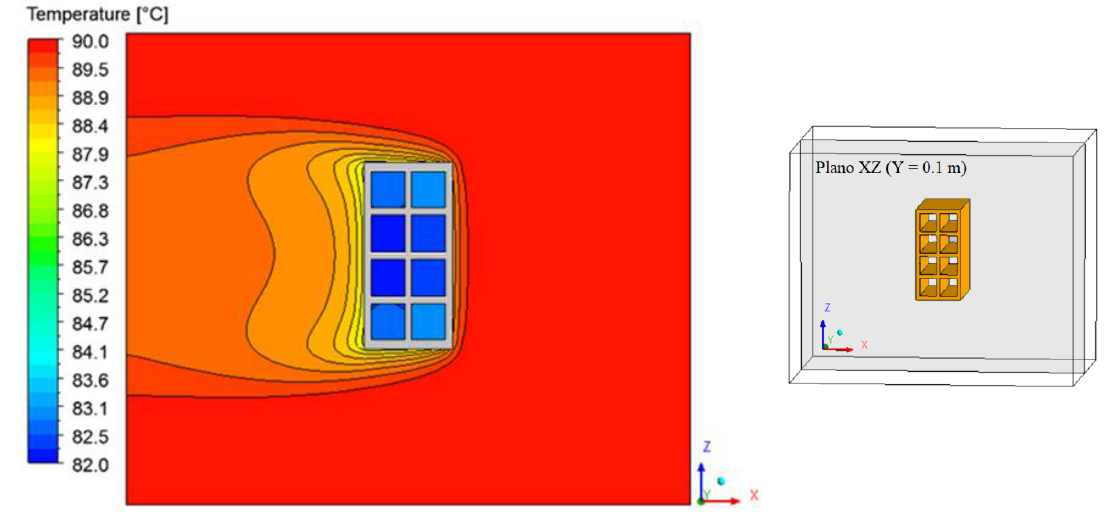
Figure 16. Air temperature distribution inside the oven (Plane XZ) for drying at 90 °C (t = 60 min).